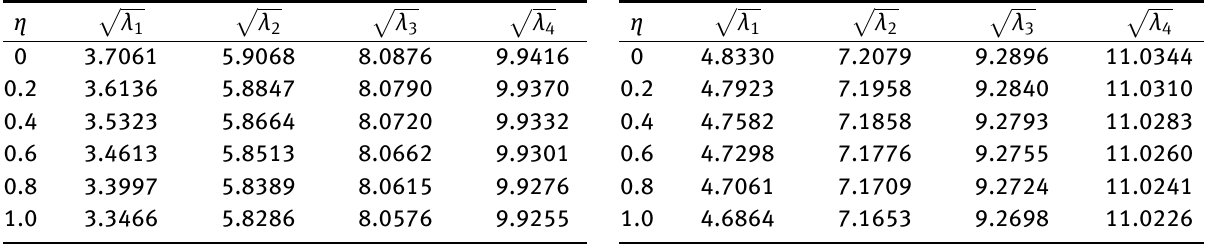
√ λ ) for CS case for different non-